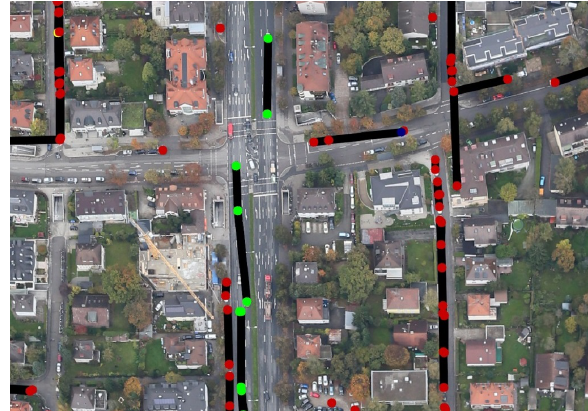
Figure 4. Vehicle queues after reducing the Delaunay graph. Queues with moving vehicles are marked green, whereas queues with stopped or parked vehicles are marked red.